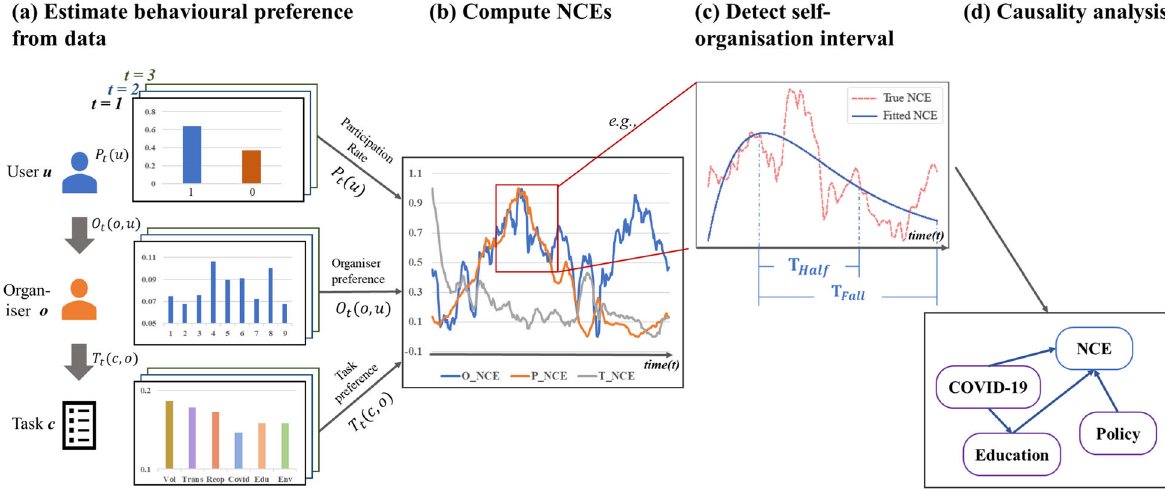
Fig. 2 Overview of our volunteer behaviour model. a Estimate the parameters in the volunteer behaviour model from the Pioneers data. The parameters, including users ’ participation rate P t u ð Þ , organiser preference O t o ; u ð Þ and task preference T t c ; o ð Þ , are visualised as probability mass functions for each timestep. b Capture the uncertainties in volunteer behaviour by computing the normalised conditional entropy (NCE) from model parameters. c Detect the time intervals when the self-organisation effect exists by fi tting a double-exponential model; quantify the self-organisation effect in terms of organisational speed measured by T Half = T Fall . d Analyse the dynamic factors that have caused self-organisation change in volunteer behaviours using time-series based causal network